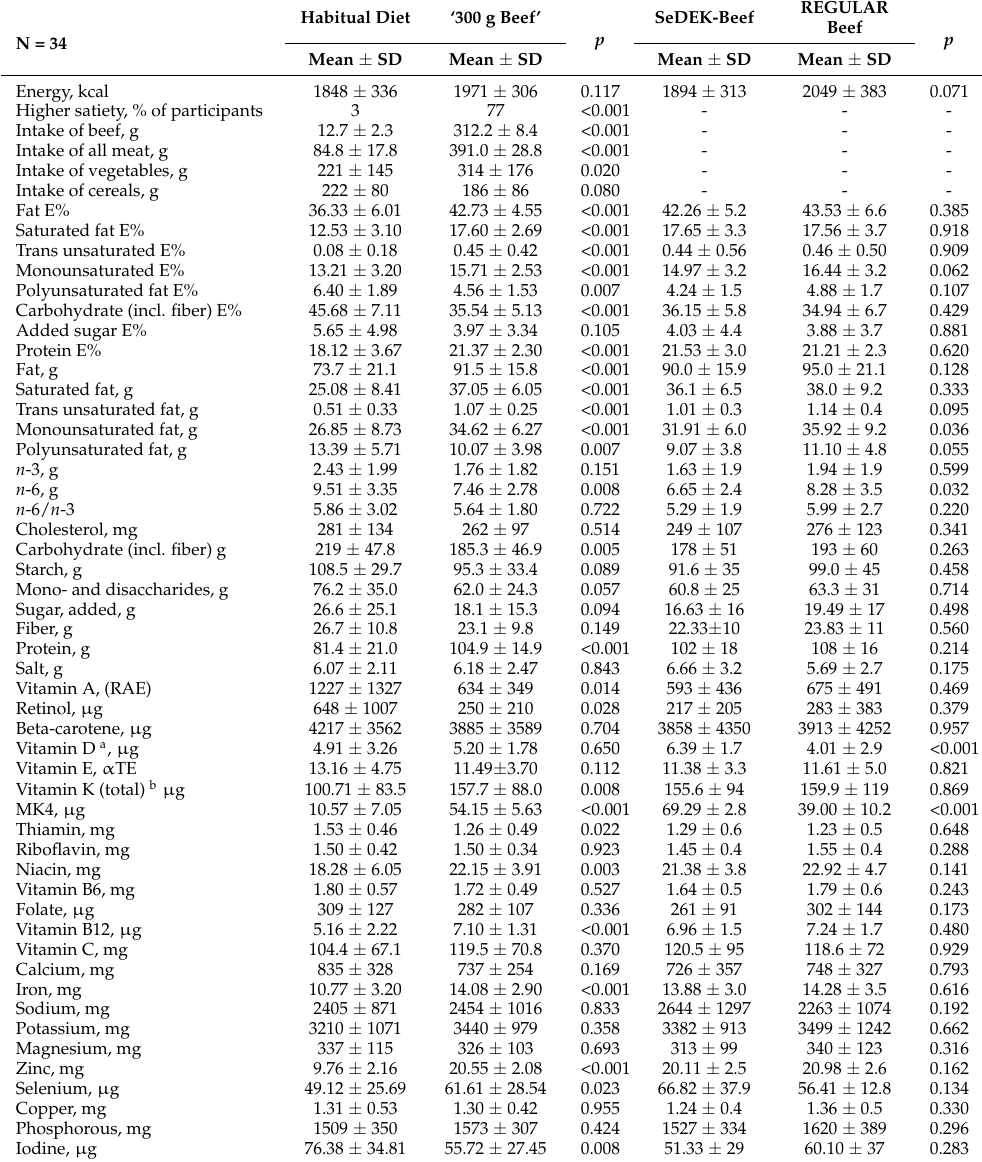
Table 3. The calculated (databases and own values) nutrient intake of 34 participants, after the 3-day food registrations, mean values, and standard deviations (SD). The ‘habitual diet’ represents the mean nutrient intakes at baseline, and the washout period, the ‘300 g beef’ represents the mean nutrient intakes when consuming SeDEK beef and REGULAR